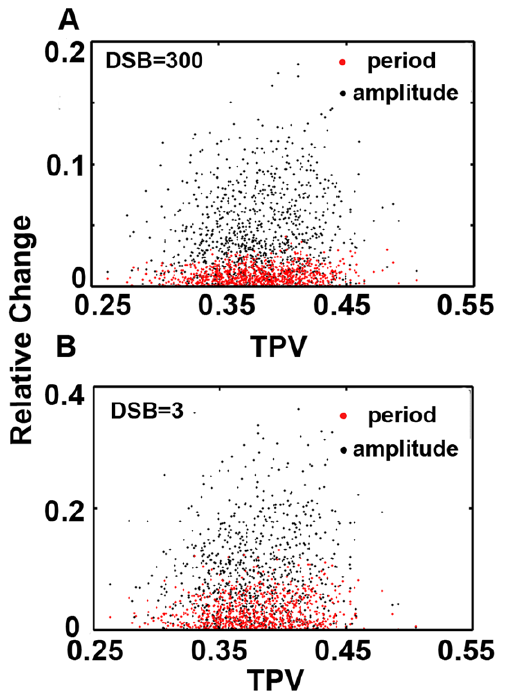
Figure 3. Amplitude and period variations. (A) DSB=300 (B) nonstressed condition. (amplitude: black, period: red).